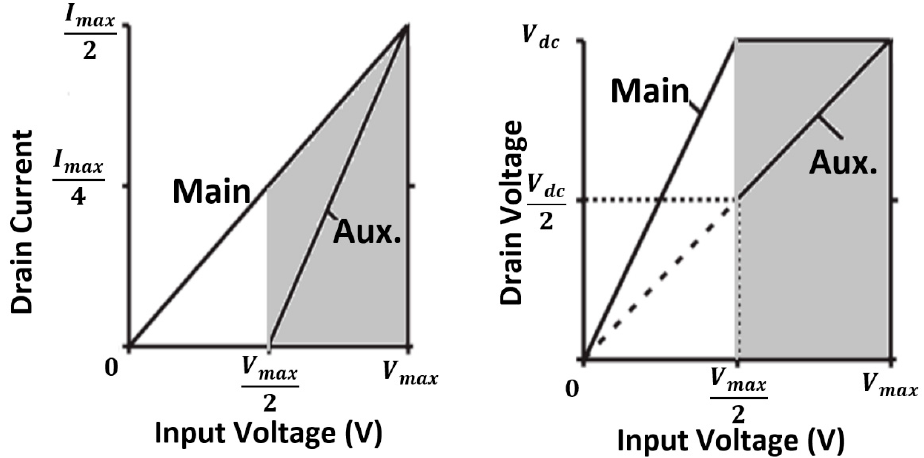
Figure 4. Voltage and current behavior of Doherty amplifier [10].